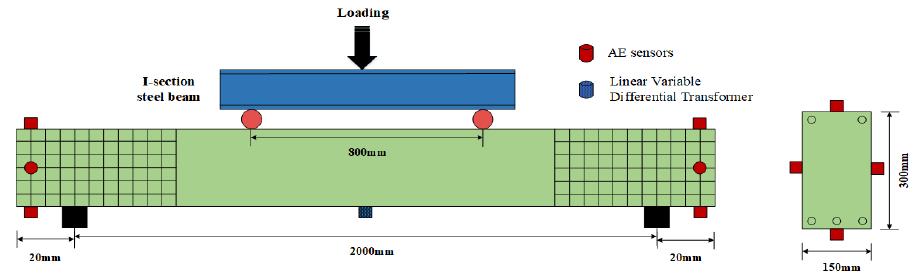
Figure 2. Schematic illustration of the four-point bending test for the RC beam.